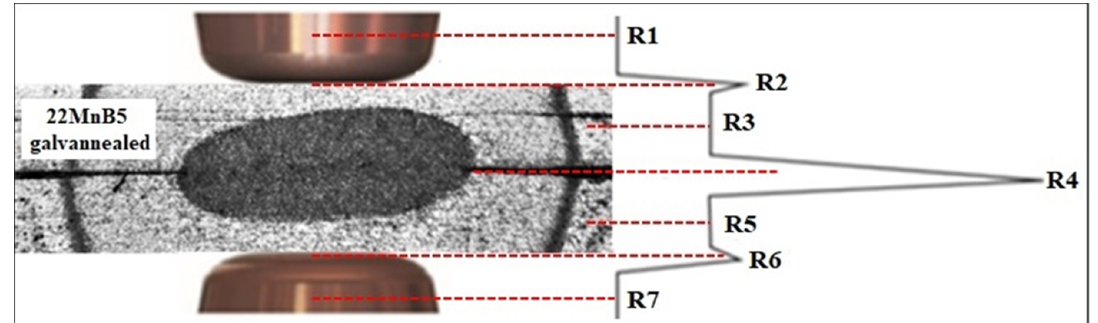
Figure 3. Resistances formed during spot welding of manganese boron steel galvannealed hot stamping.